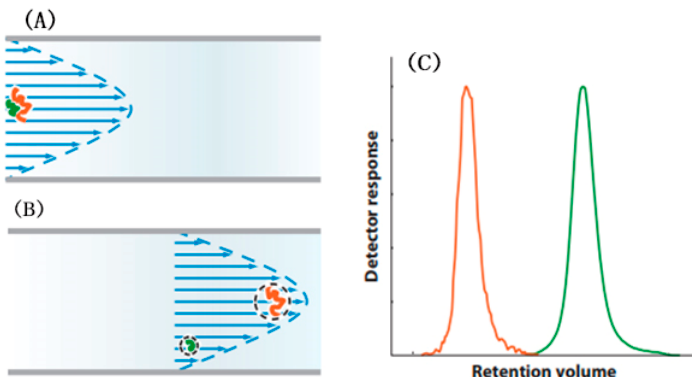
Figure 6. Separation mechanism of hydrodynamic chromatography. ( A ) A parabolic profile forms during the separation process; ( B ) The large-sized analyte locates at the center of profile, and the small-sized analyte stays close to the wall of the channel; ( C ) Chromatographic peaks of large- and small-sized analytes. Adapted from Striegel et al. [45] Copyright 2012 Annual Reviews 2012.